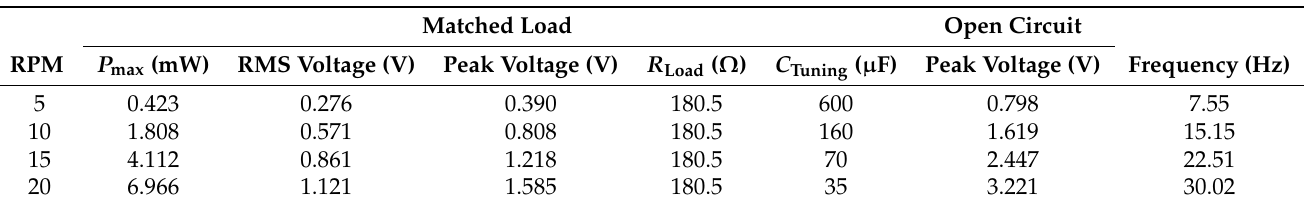
Table 3. Electrical performance of the VREH transducer at different rotational speeds under matched load and open circuit